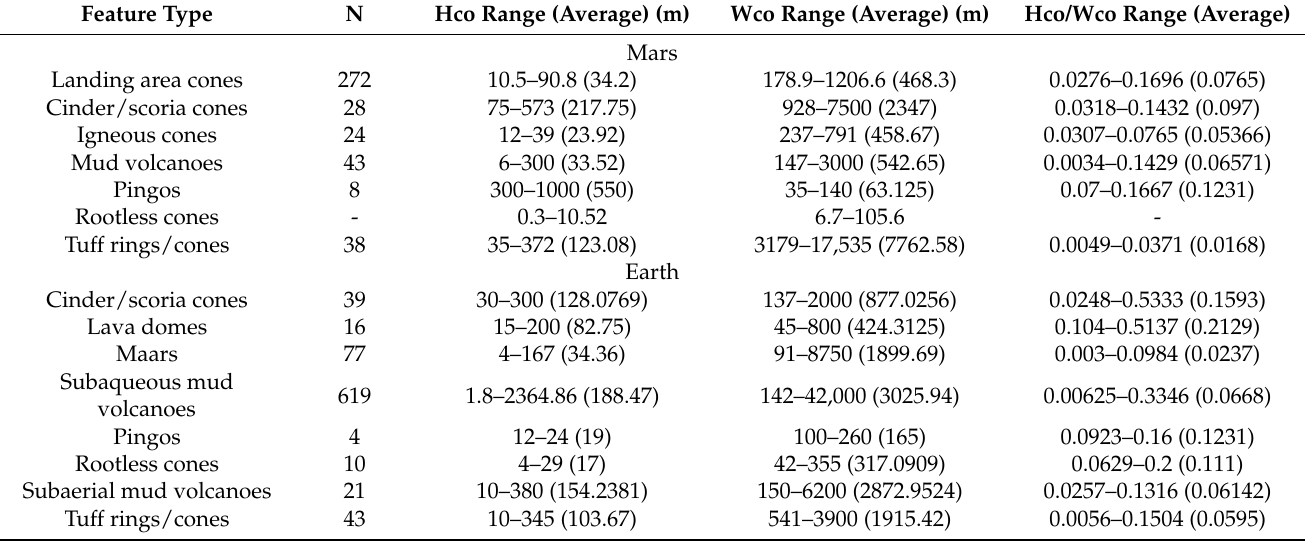
Table 1. A summary of morphometric parameters of the features shown in Figure